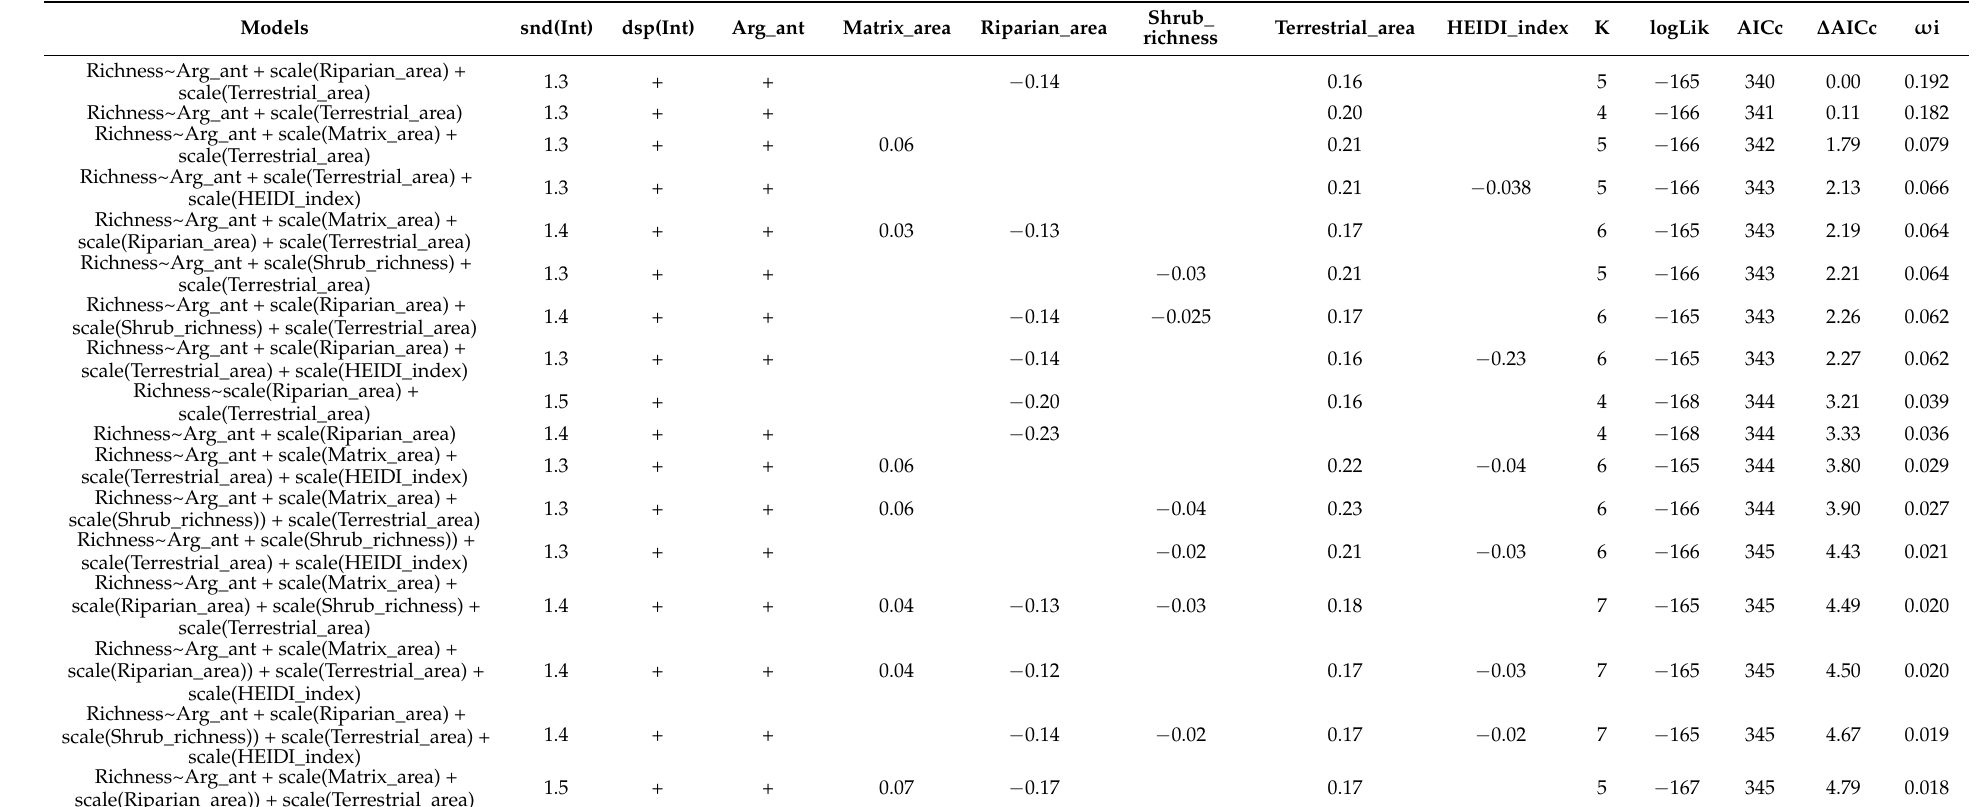
Table A2. Description of the GLMMs relating the effects of different predictors on the ant species richness in the ecological infrastructure (EI) patches. Models are ranked in ascending order of AIC values and the number of parameters in the model (K), log-likelihood (logLik), AICc, ∆ AICc, and AICc weight ( ω i) are given for each model. The “+” signal means the inclusion of the nominal variables in the